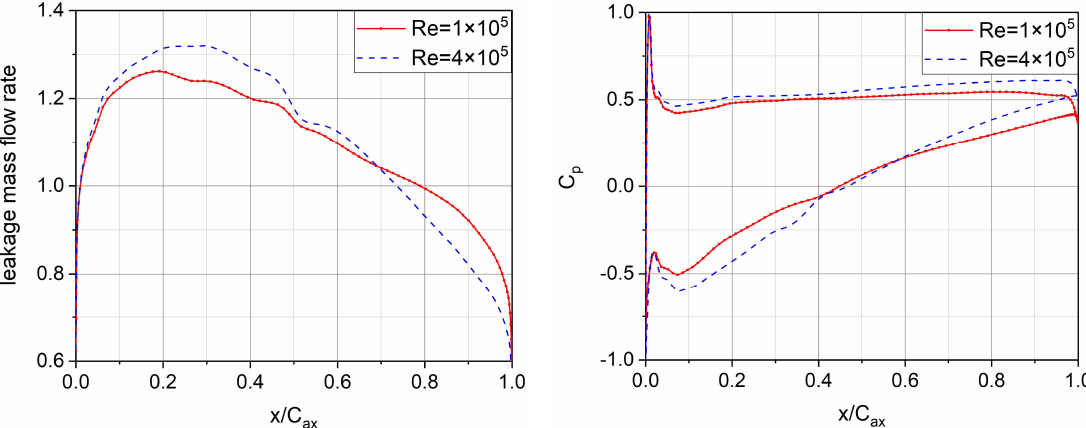
Figure 18. Distribution of tip clearance leakage flow rate and static pressure coefficient at 99% span.